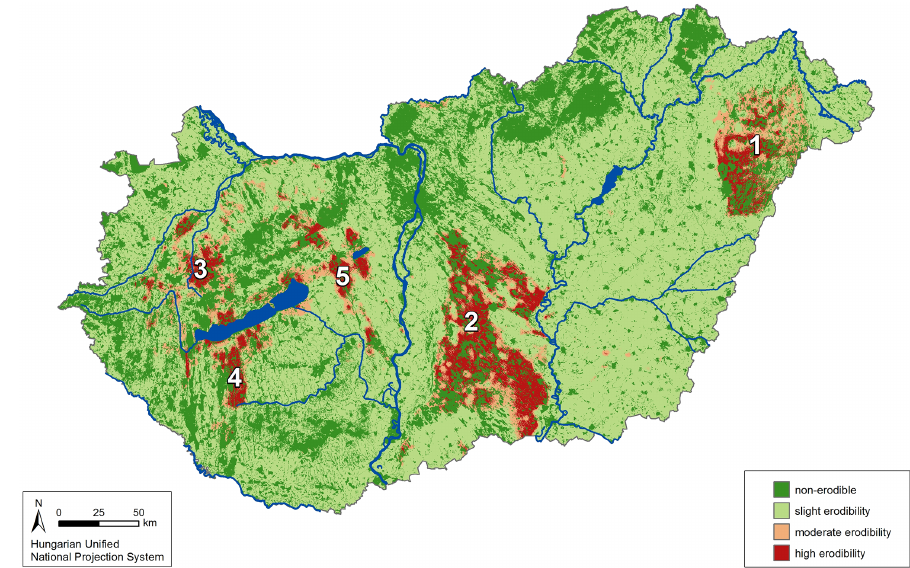
Figure 9. Categorised wind erosion susceptibility map of the Hungarian soils. The five distinct areas with typically higher wind erosion risk are numbered: Nyírség (1), Danube–Tisza Interfluve (2), glacis in the foreground of the Transdanubian Mountains (3), Inner Somogy (4), Transdanubian loess region